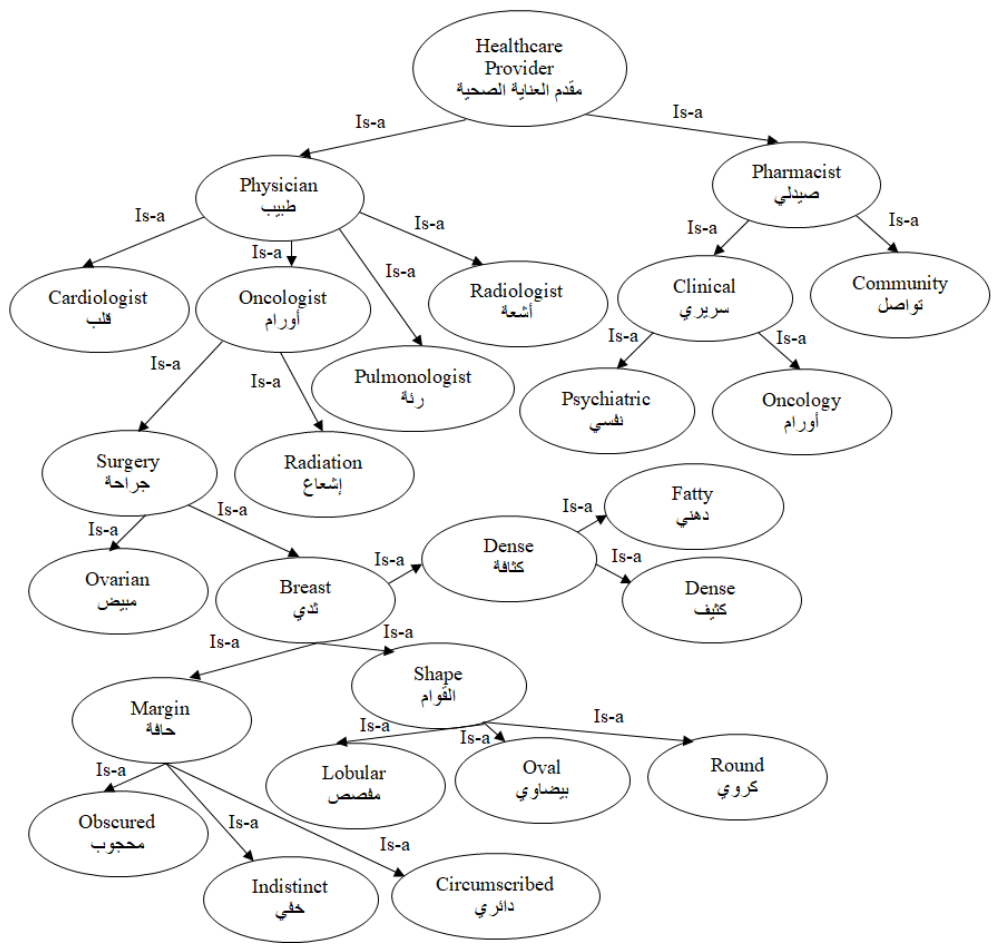
Figure 1. Representation of some biomedical concepts in our corpus which have an Is-a semantic relationship.